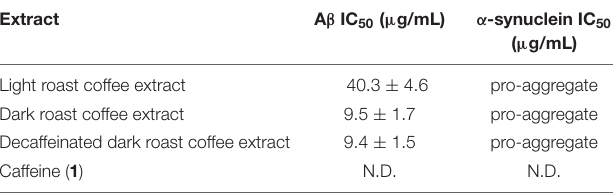
TABLE 3 | IC 50 values for coffee extracts and caffeine in oligomer assays. a